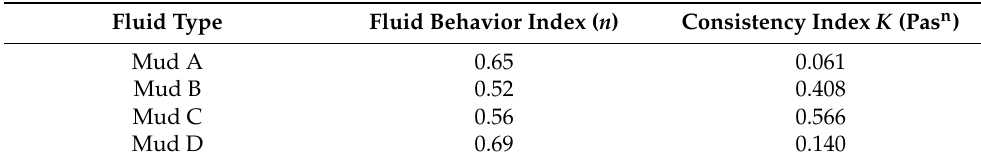
Table 2. Properties of fluids used for CFD validation.